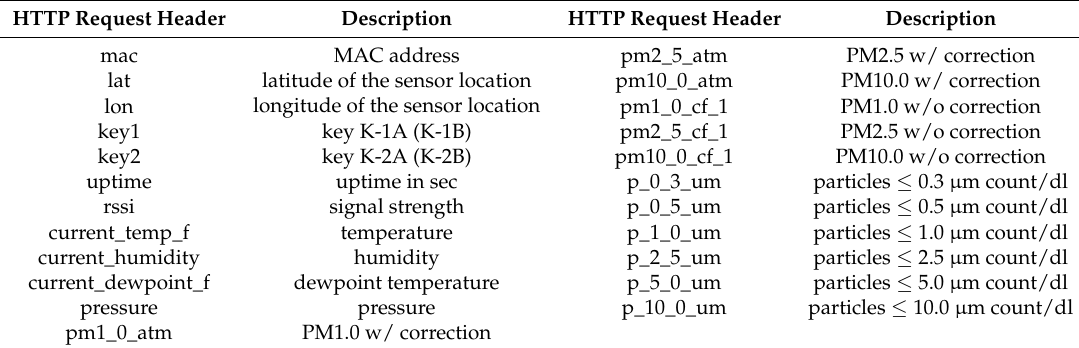
Table 1. Data format description for M-1A and M-1B.